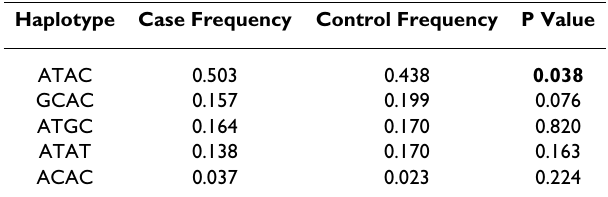
Table 5: Haplotype frequencies for ARNT SNPs in African American cases and controls Haplotype Case Frequency Control Frequency P